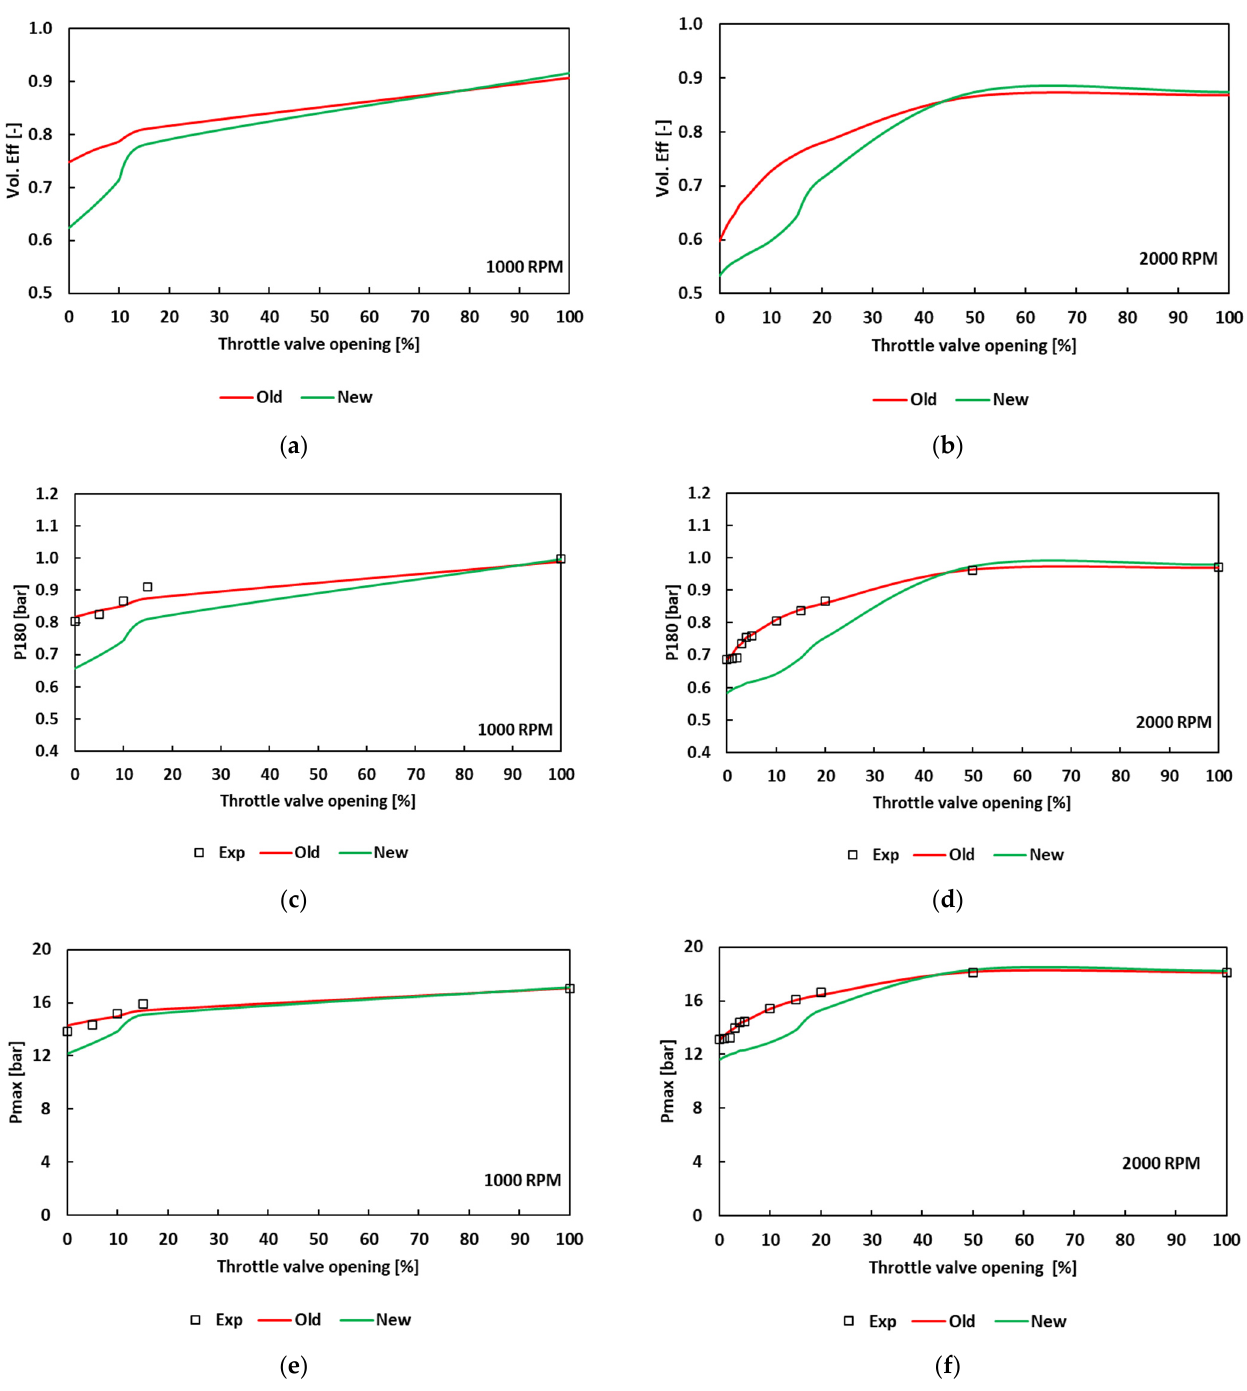
Figure 6. Volumetric efficiency, in–cylinder pressure at 180 deg bTDC, and its peak value for motored conditions at 1000 ( a , c , e ) and 2000 rpm ( b , d , f ); measurements are sown (only for the old design) with squared symbols.